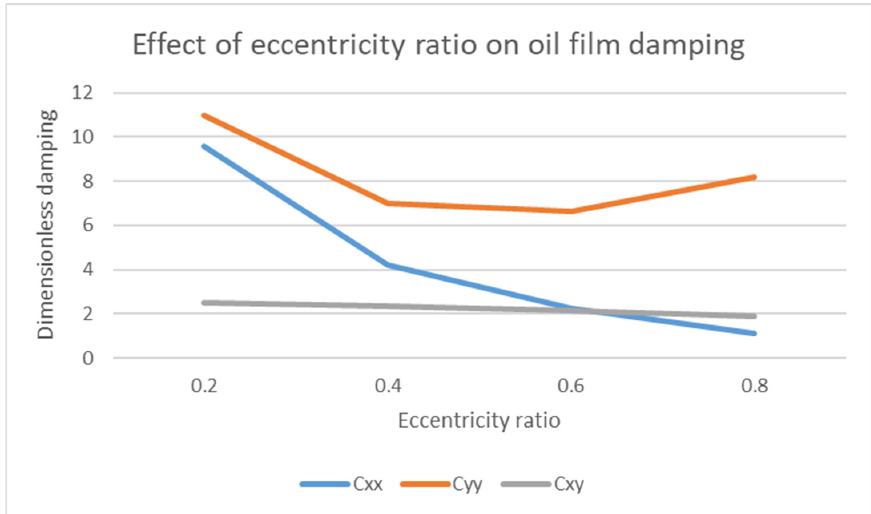
Figure 7. Effect of eccentricity ratio ε on dimensionless damping C